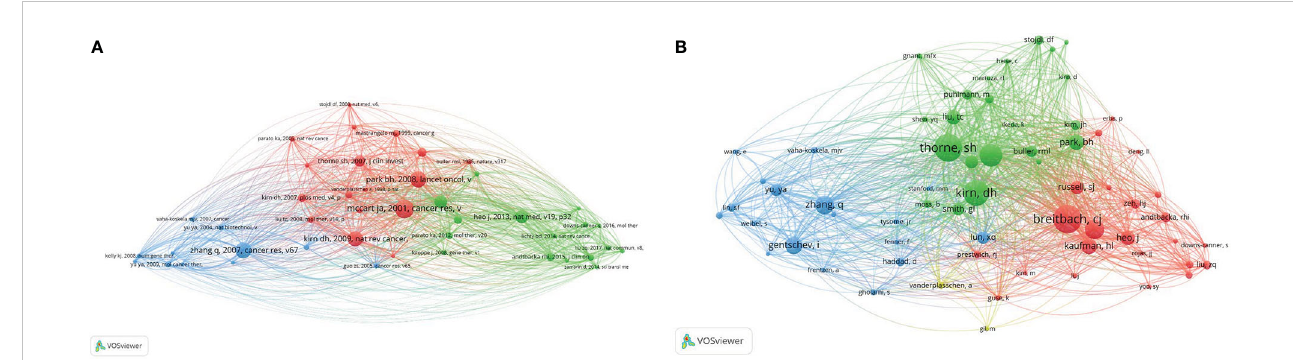
FIGURE 7 Co-cited references and co-cited scholars. (A) Network map of co-cited references. Of the 10,812 references, 44 (classi fi ed into three clusters) had been cited at least 25 times. (B) Network map of co-cited scholars. Of the 8,405 scholars, 65 (classi fi ed into three clusters) had been cited at least 25